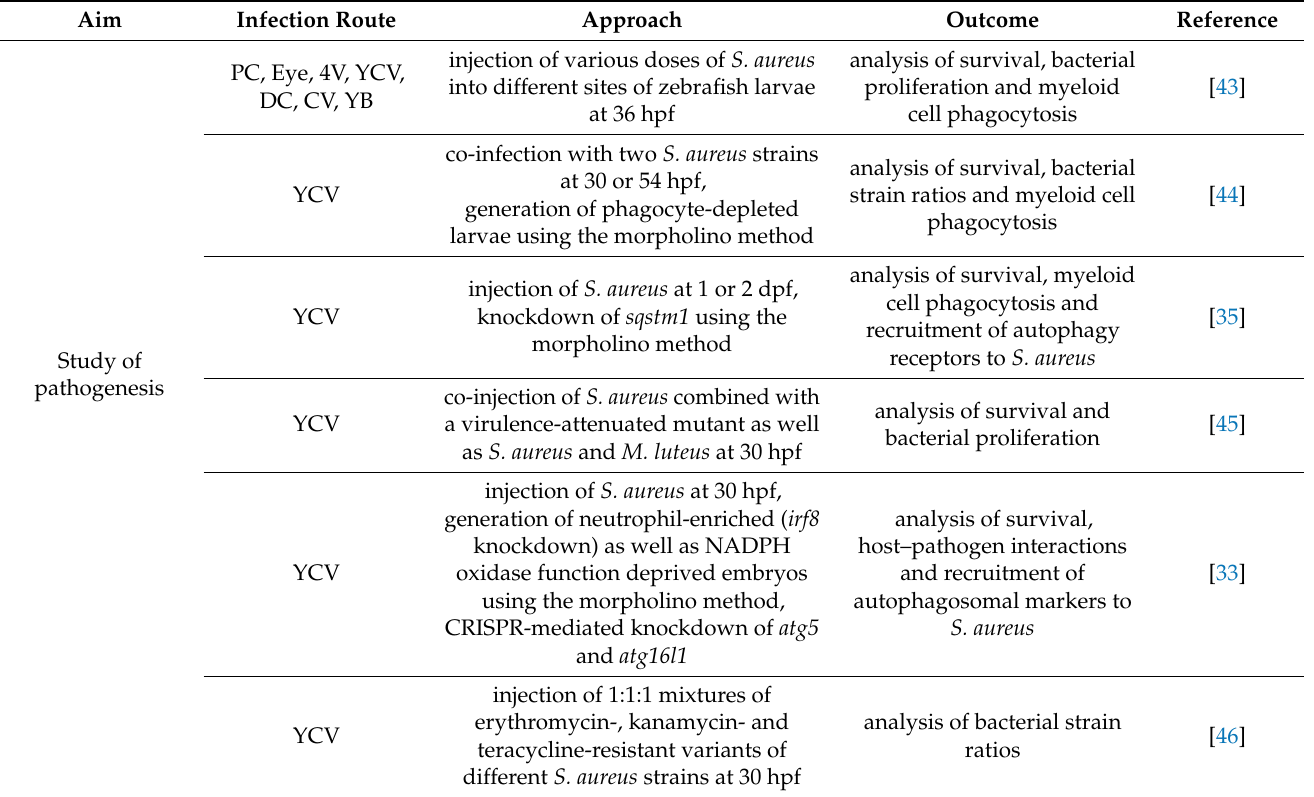
Table 1. Reported studies of zebrafish larvae models to investigate Staphylococcus aureus disease biology. PC: pericardial cavity; 4V: fourth hindbrain ventricle; YCV: yolk circulation valley; DC: Duct of Cuvier; CV: caudal vein; PCV: